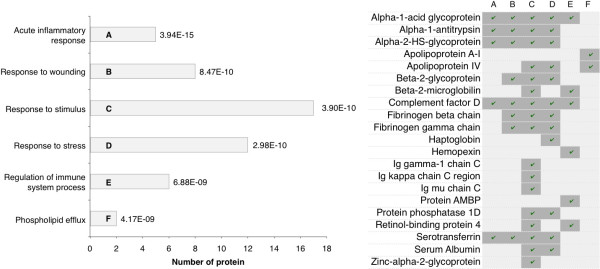
Gene ontology annotation, the horizontal bars represent the number of protein identified in peritoneal dialysis effluent and involved in each biological process. The p-value calculated for each biological pathway is shown over the bar. A acute inflammatory response; B response to wounding; C response to stimulus; D response to stress; E response of immune system process; F phospholipid efflux. In the table on the right are shown the protein involved in each biological pathway.